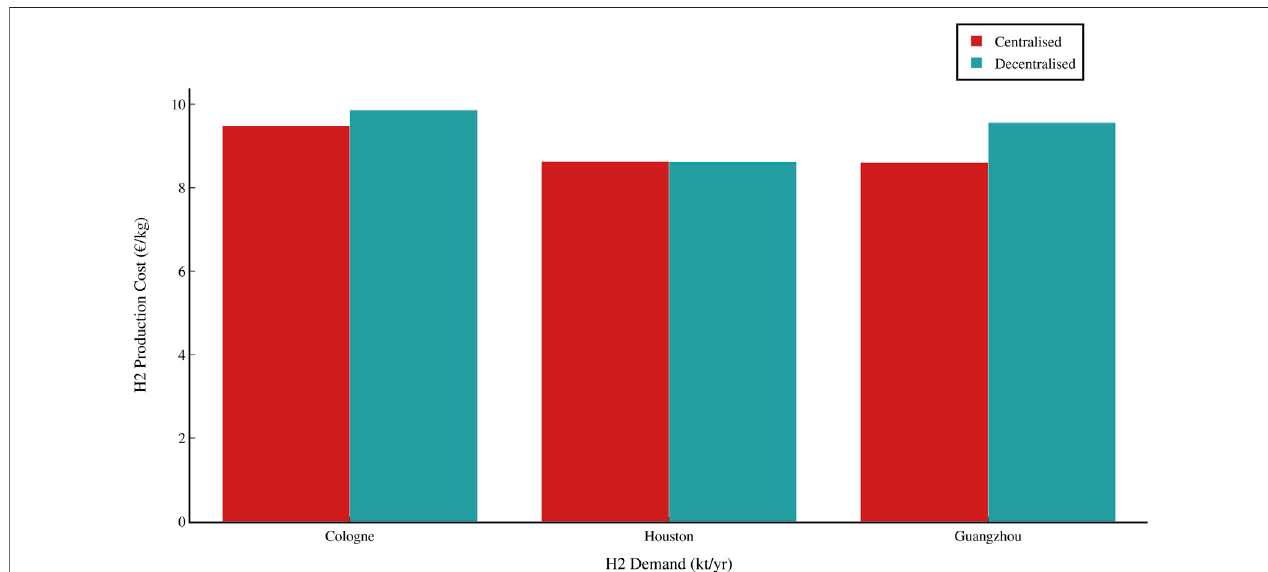
FIGURE 12 | Lowest cost of producing and transporting H 2 to Cologne, Houston and Guangzhou for the baseline scenario (100 kt/y AE electrolyser in 2030), showing both centralised and decentralised reconversion to gaseous H 2 . Results are from a Monte Carlo simulation with 1,000 iterations.